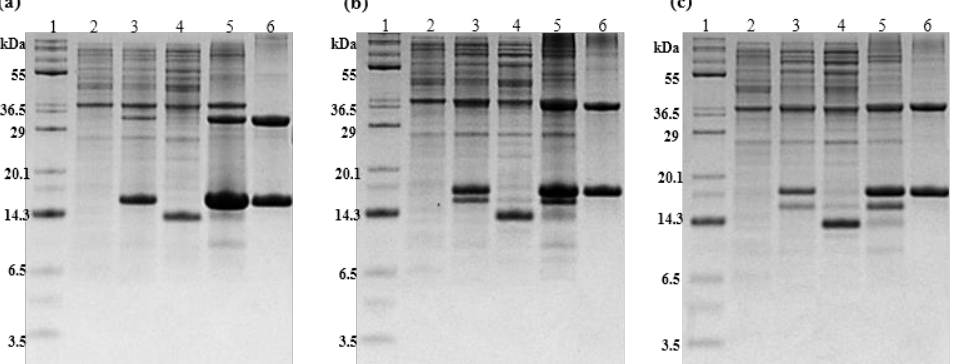
Figure 1. Confirmation of the expression and isolation process of three tIK peptides, ( a ) tIK-9mer, ( b ) tIK-14mer, and ( c ) tIK-18mer using 12% Tris – tricine polyacrylamide gel electrophoresis. Lane 1: molecular weight marker; lane 2: before induction; lane 3: after induction; lane 4: supernatant of cell lysis; lane 5: pellet of cell lysis; lane 6: after Ni-NTA affinity chromatography. The fusion protein band was found around 16 – 17 kDa in lane 5.